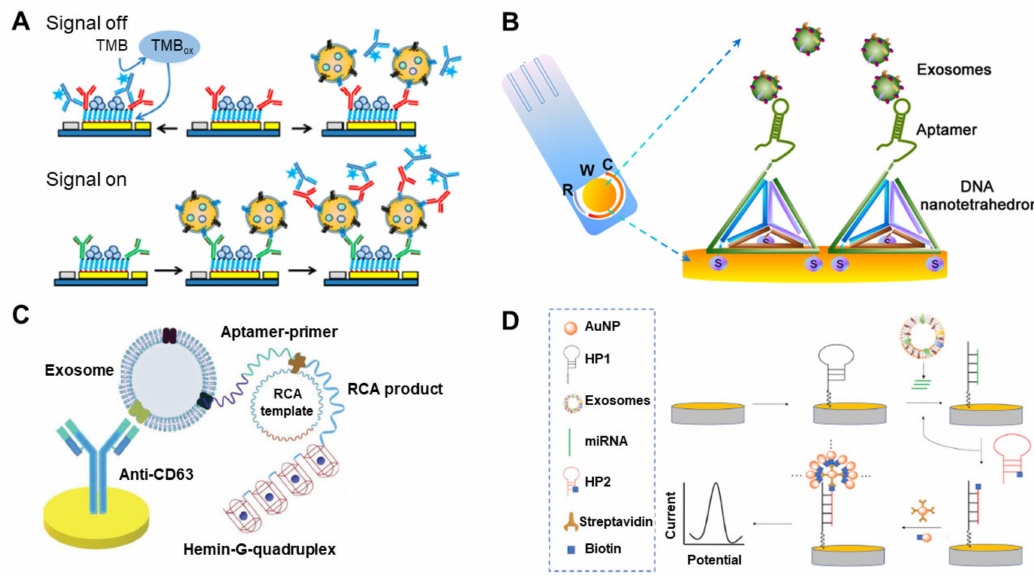
Figure 3. Electrochemical biosensor for EV detection. ( A ) Schematic diagram of the electrochemical sandwich immunosensor with an enzyme for measurement of EVs; ( B ) electrochemical aptamer-based sensor using DNA nanotetrahedron as a capture moiety on the electrode; ( C ) hemin / G-quadruplex-assisted signal amplification for sensitive electrochemical detection of EVs from gastric cancers; ( D ) signal amplification strategy for electrochemical EV detection by using hairpin DNA-functionalized silver nanoparticles. (reproduced with permission from [75], published by American Chemical Society 2016, reproduced with permission from [79] published by American Chemical Society 2017, reproduced with permission from [80] published by WILEY-VCH 2019 and reproduced with permission from [81] published by Elsevier